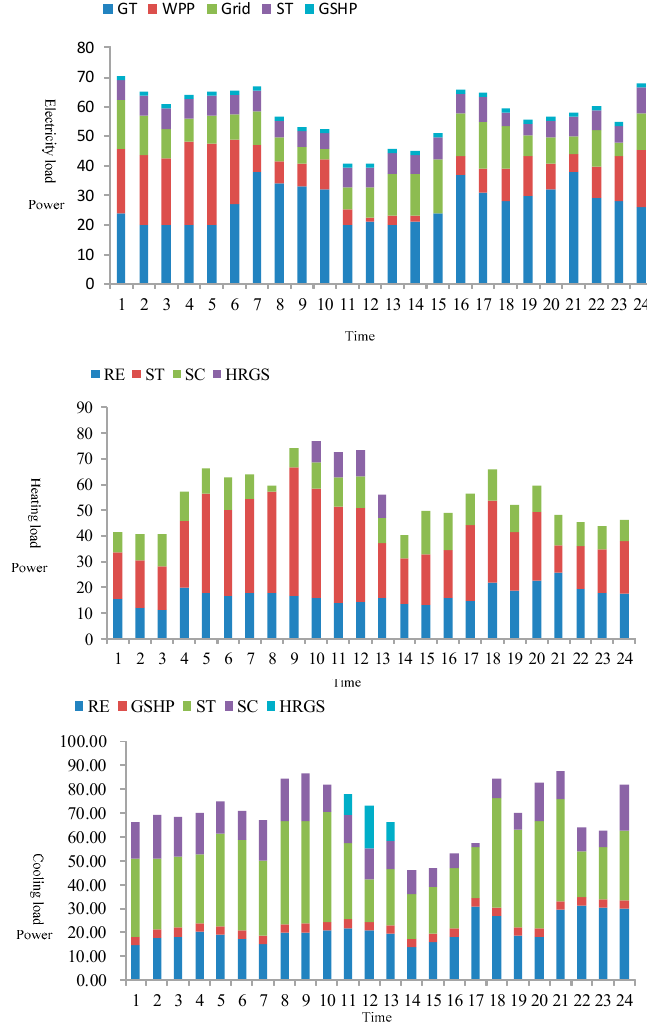
Figure 7. Hourly electric, heating, and cooling load supply of scenario 3 (unit: MW).